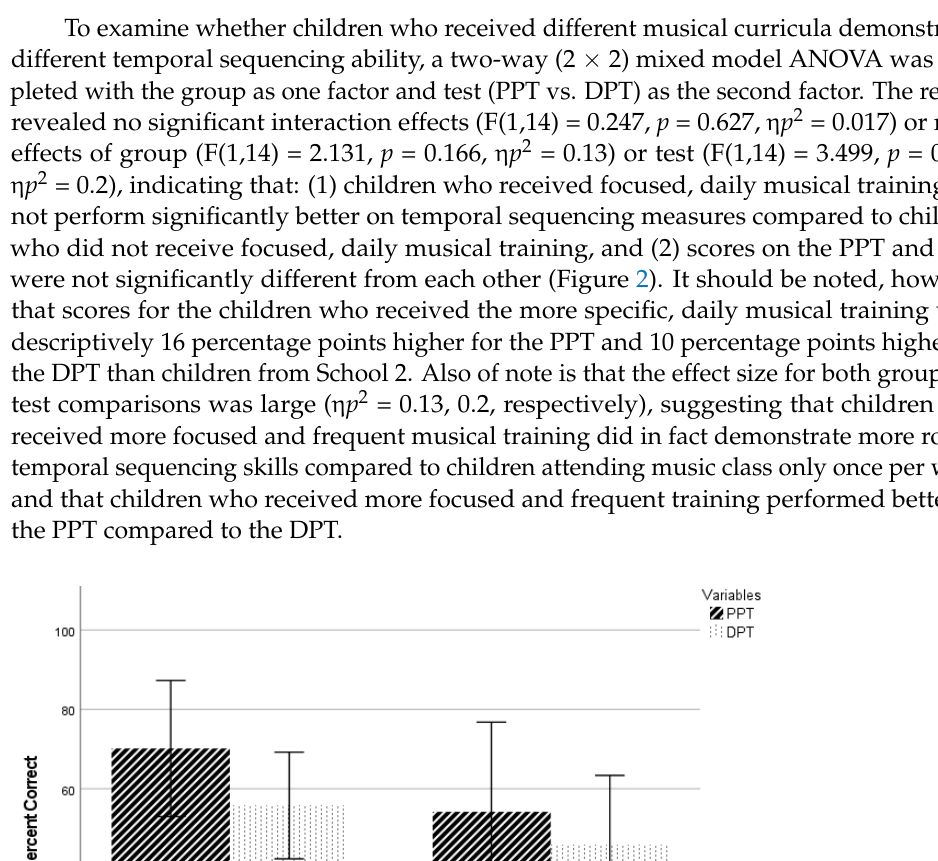
Figure 1. Mean pitch discrimination scores (DLF) showing variance for each group.